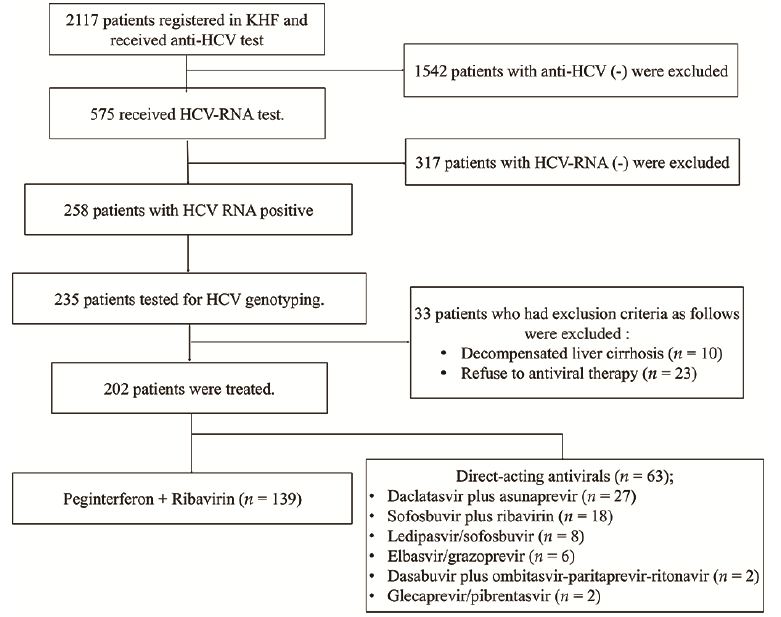
Figure 1. Flow and exclusion of study participants. KHF, The Korea Hemophilia Foundation; HCV, hepatitis C